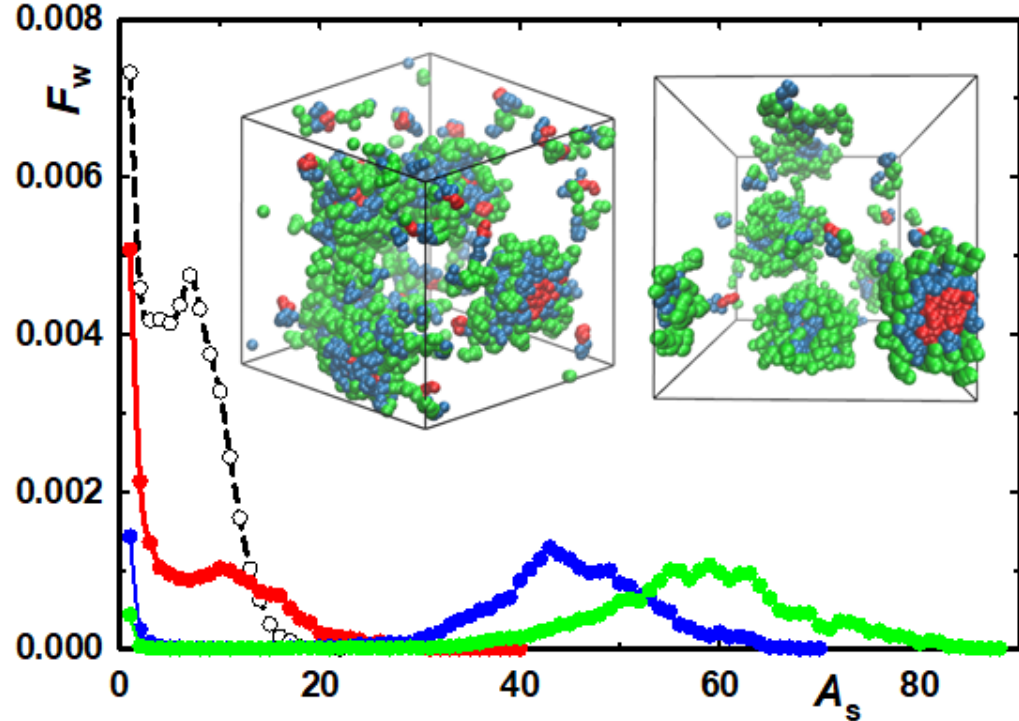
Figure 11. Weight distribution function, F w ( A s ), of association numbers, A s , for the pre-aggregated micelles A 5 B 5+ with ∆ a BS = 0 (B block compatible with the solvent—black dashed curve), for onion micelles formed by A 5 B 5+ micelles and C 7 B 5 − chains with ∆ a BS = ∆ a BC = ∆ a BI = 0 (B block compatible with the solvent, with block C and with counterions—red curve) and for systems with increasing compatibility of blocks ( ∆ a BS = ∆ a BC = ∆ a BI = 3.5—blue curve and ∆ a BS = ∆ a BC = ∆ a BI = 5.0—green curve). The left-hand-side insert shows a typical snapshot of associates with ∆ a BS = ∆ a BC = ∆ a BI = 3.5 and the right-hand-side one shows a snapshot for the value of 5 (beads A—red, beads B—blue and beads C—green). (Reprinted with permission from Macromolecules 2020 , 53 ,